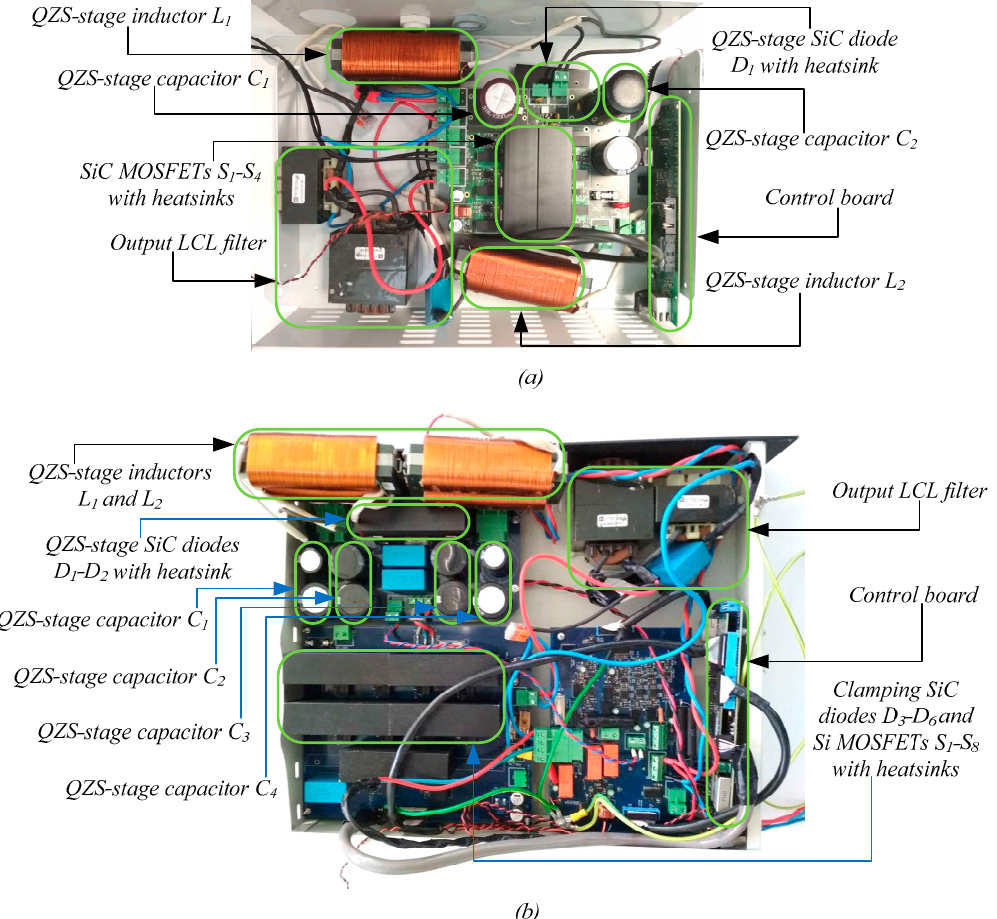
Figure 5. Experimental prototypes of the 2L QZSI ( a ) and the 3L NPC QZSI ( b ).